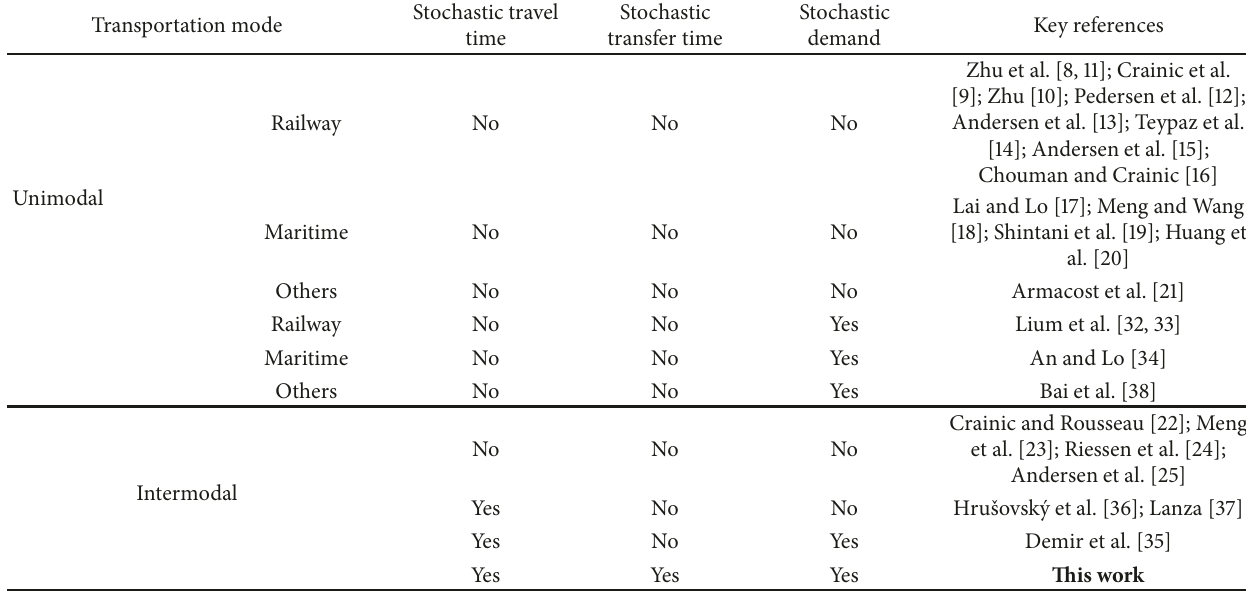
Table 1: Overview of service network design